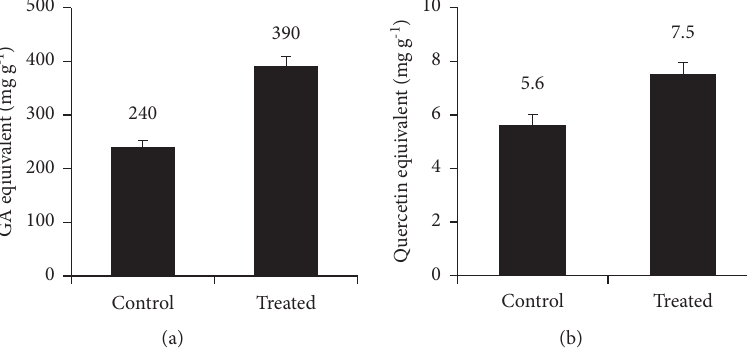
Figure 2: Effect of leaf extracts of Glycyrrhiza uralensis on total phenolic (a) and flavonoid (b) contents of Chinese flowering cabbage under field conditions. Data presented here are mean values of two independent field trials. Vertical bars show standard error, whereas small letters show levels of significance among different treatments as governed by ANOVA and DNMRT at p � 0 .